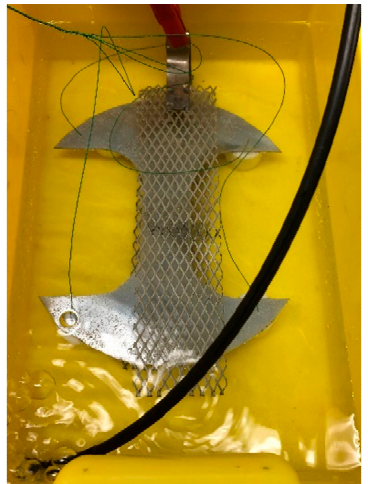
Figure 2. Experimental setup for hydrogen charging.